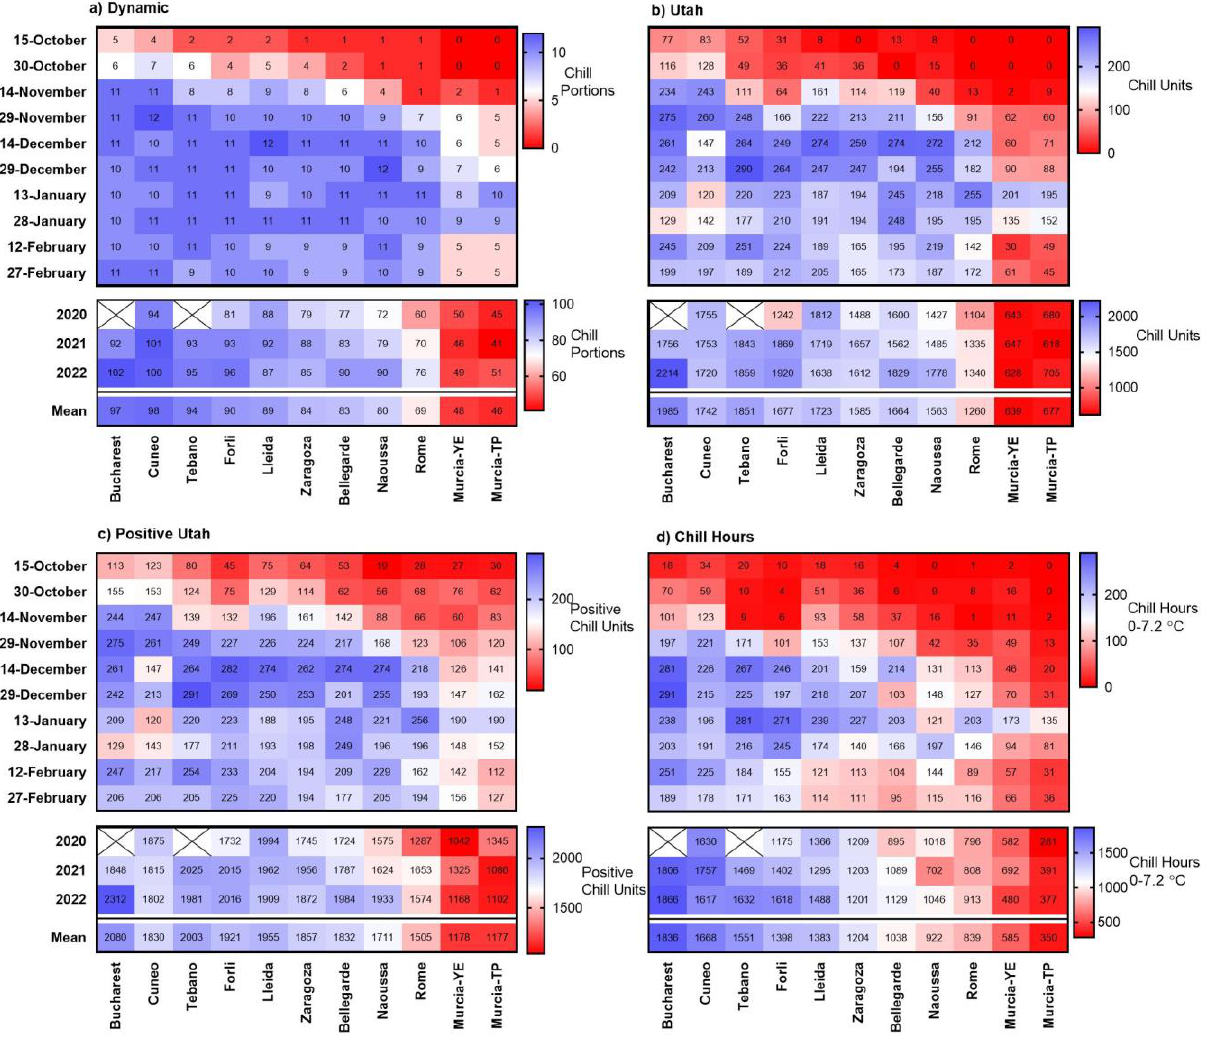
Figure 2. Heat-maps presenting the sum of chill accumulation during 15-d periods (from 1 October to 29 February) and yearly sums (2019–2022) and calculated with the ( a ) Dynamic (Chill Portions), ( b ) Utah (Chill Units), ( c ) Positive Utah (Positive Chill Units) and ( d ) Chill Hours models. X = no data. YE = Yéchar; TP = Torre Pacheco.